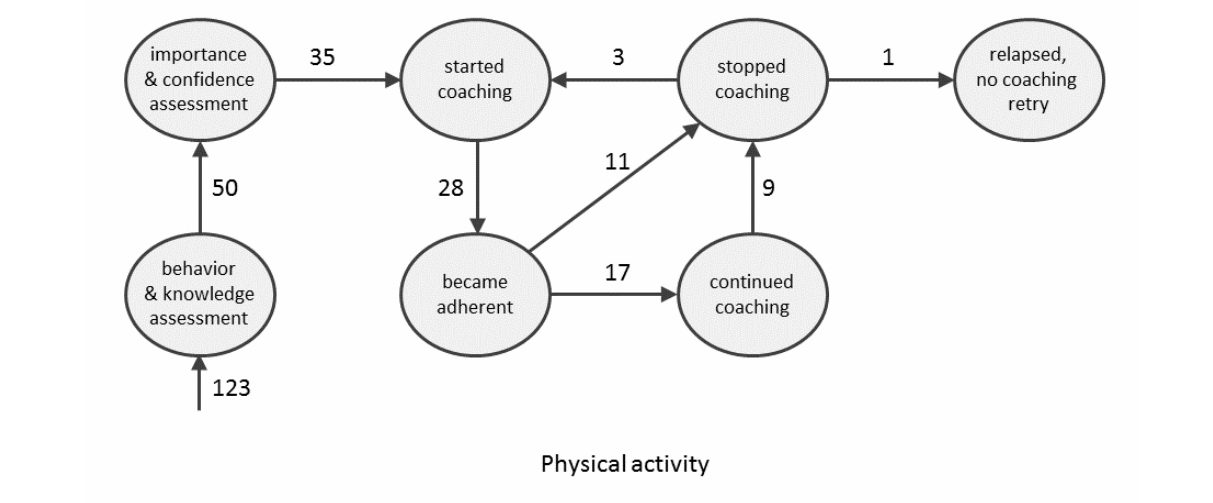
Figure 3. The states (circles) and transitions (arrows) in the coaching process. The numbers at the arrows indicate the number of patients who made this transition for physical activity at least